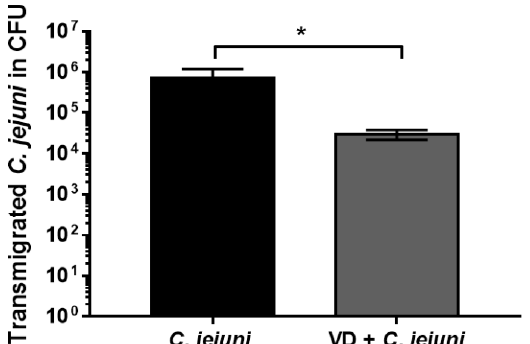
Figure 7. Transmigration of C. jejuni across intestinal epithelial cell monolayers. HT-29/B6-GR/MR cells were treated with 200 nM vitamin D and infected with C. jejuni from the apical side. Eight hours after infection, bacteria that had transmigrated into the basolateral compartment were collected from the bathing medium and quantified by counting CFU on blood agar plates (* p < 0.05, Mann–Whitney U-test, n = 11–16).